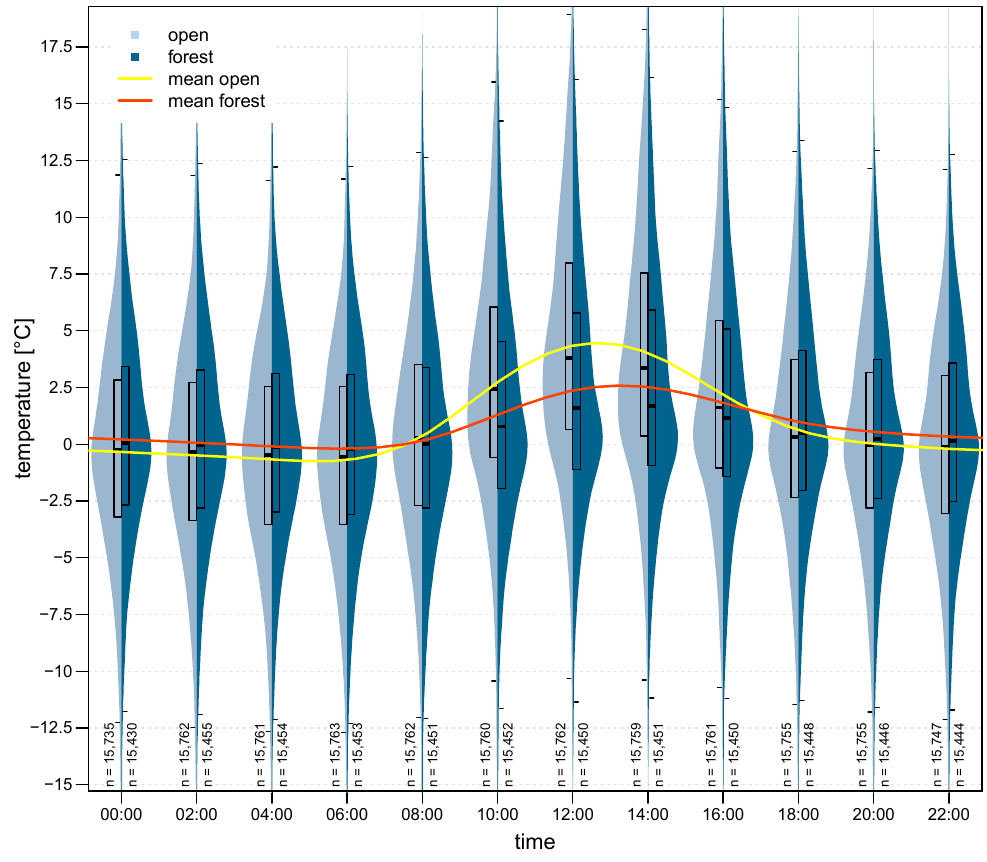
whisker (representing 1.5 times of the box border values). The yellow line symbolizes the mean air temperatures in the open field at each time step and the red line represents the mean air temperatures in the forest. The course is drawn by a spline line, so values between two time steps are interpolated. The mean dampening due to forest effects results in lower average air temperatures between 08:00 and 16:00 o’clock and higher air temperatures from 18:00 to 06:00 o’clock.